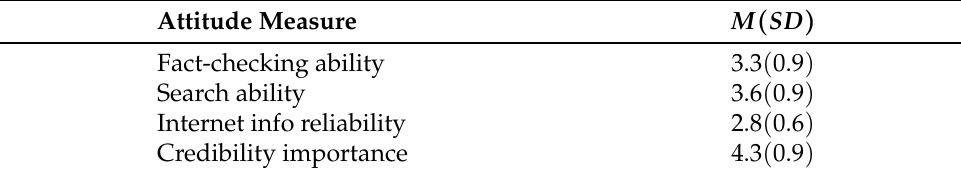
Table 4. Means and standard deviations (in parentheses) for fact-checking ability, search ability, internet info reliability, and credibility importance based on a five-point rating